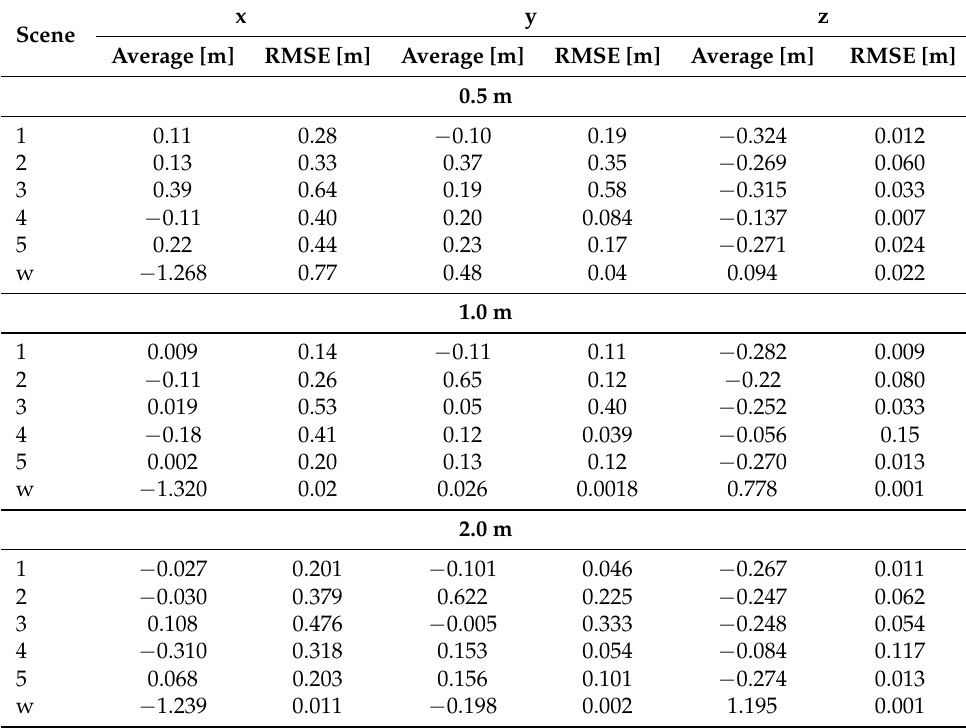
Table 1. Results of the scenes with Point Cloud GSD: 0.5m and grid size: 1 m .